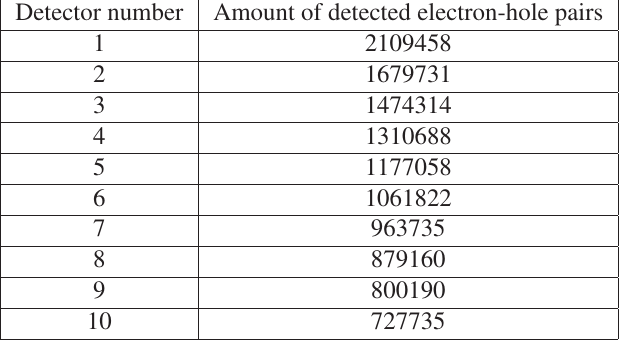
Figure 2. Model of beta-converter in GEANT4 Figure 3. Model made to determine the optimal depth of the p-n junction the thickness of the Space charge region area of the p – n junction (red) is 3 µ m. The p-SiC (green) layer is 5 µ m. The rest of the volume is occupied by a silicon substrate (blue). with carbon-14 remained. Under it were created layers of detectors with a thickness of 1 Simulation progress: micron each. The detector number corresponds to its depth under the n-SiC14 layer. The detectors record the number of formed electron-hole pairs at a certain depth. The results of 10 7 simulations of this model for the first 10 detectors are shown in Table 1. Table 1. Result of